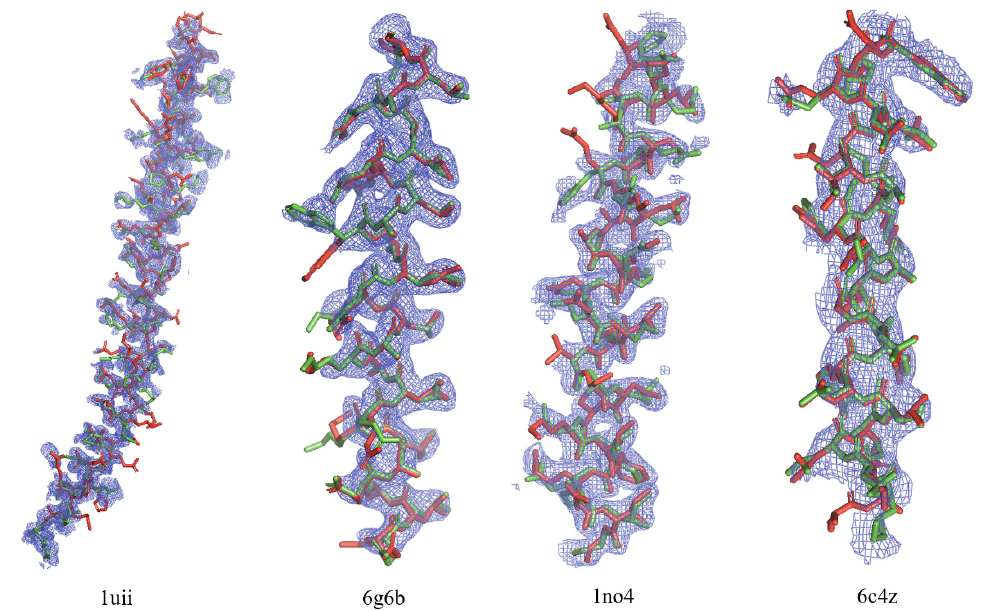
Figure 11. The calculated density maps (blue mash) of one α -helix, reconstructed models (green sticks) and the PDB posted models (red sticks) of 1uii, 6g6b, 1no4 and